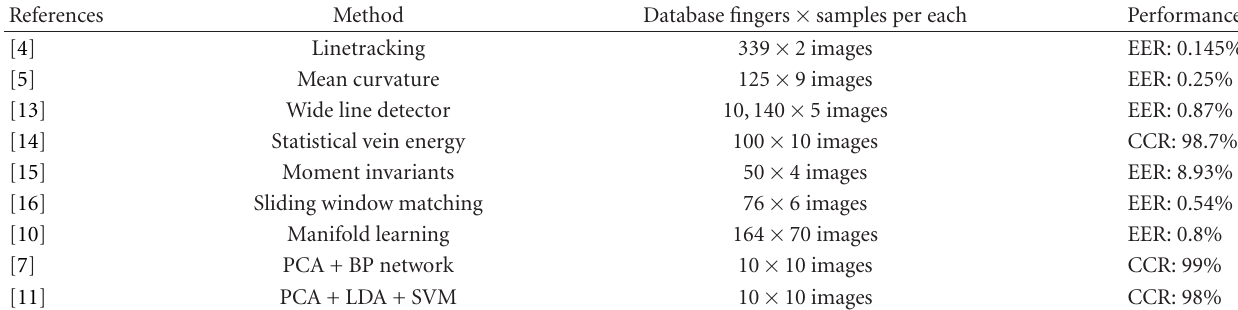
Table 1: Methods for personal authentication using finger vein